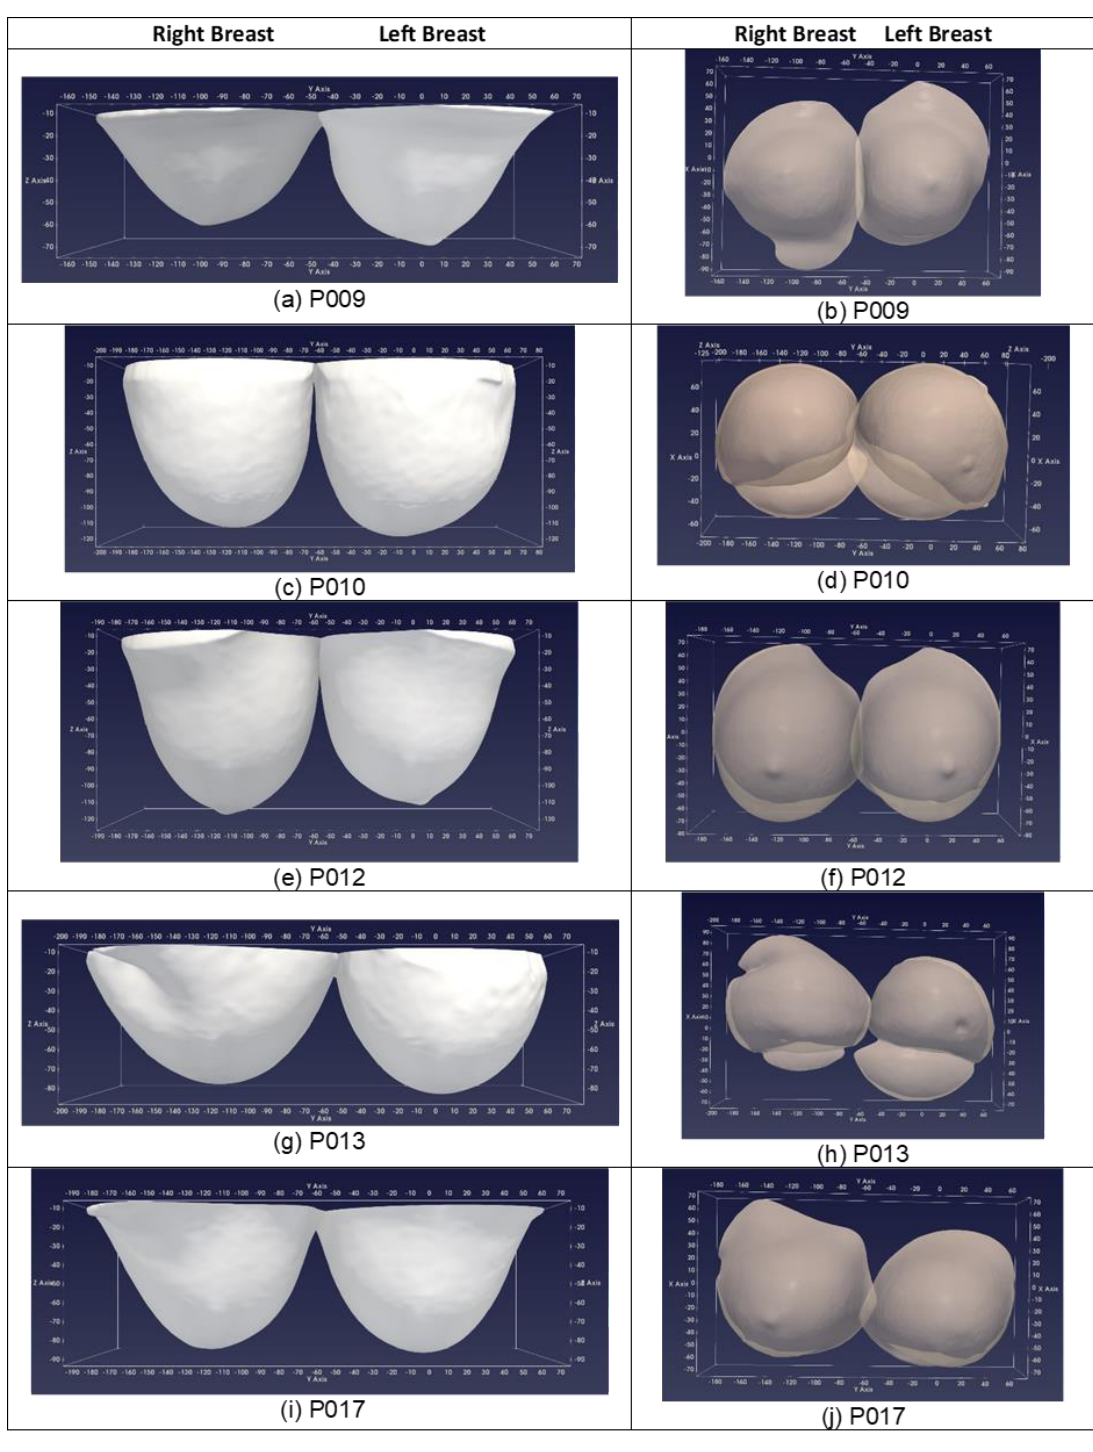
Figure 34. Breast Anatomy, as seen in the Wavelia OBCD scanner: Side view ( Left ), Supine position mimicking view ( Right ) - the second series of five patient scans.